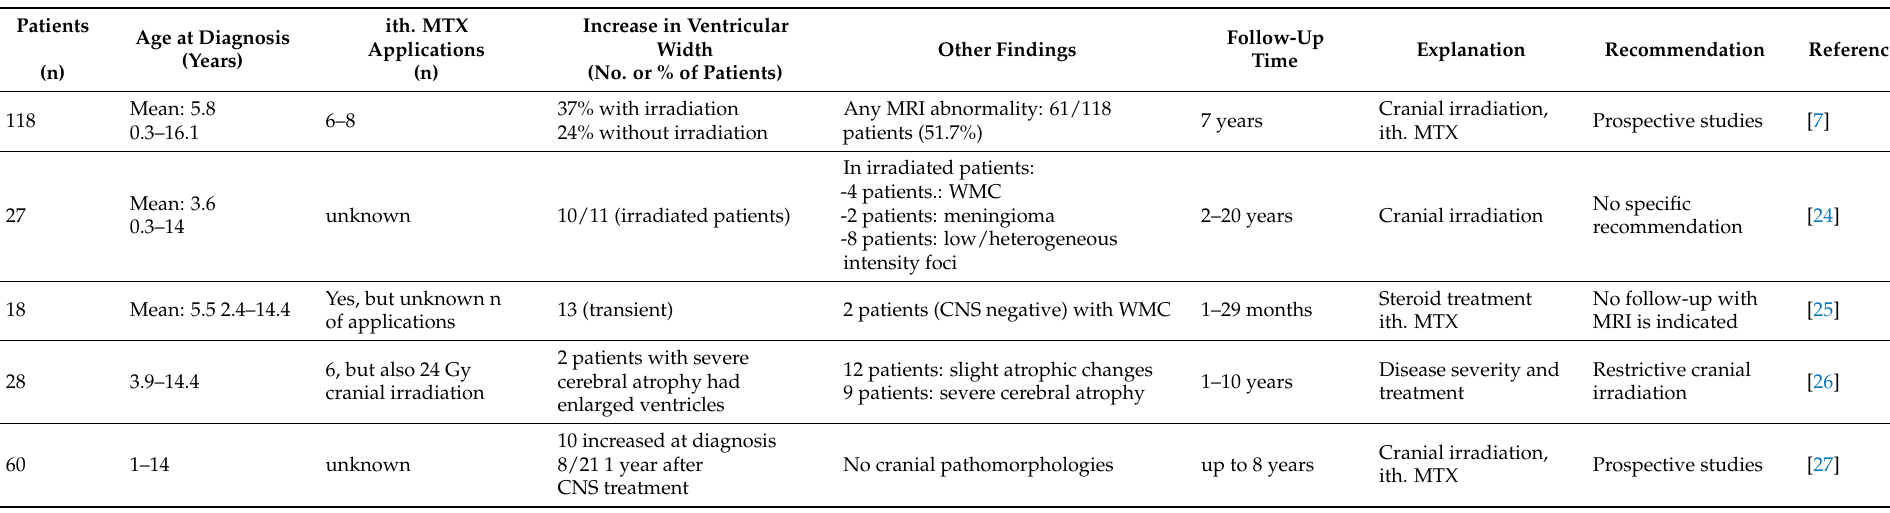
Table 5. Summary of studies dealing with ventricular width in patients with ALL. (CNS: central nervous system; ith.: intrathecal; WMC: white matter